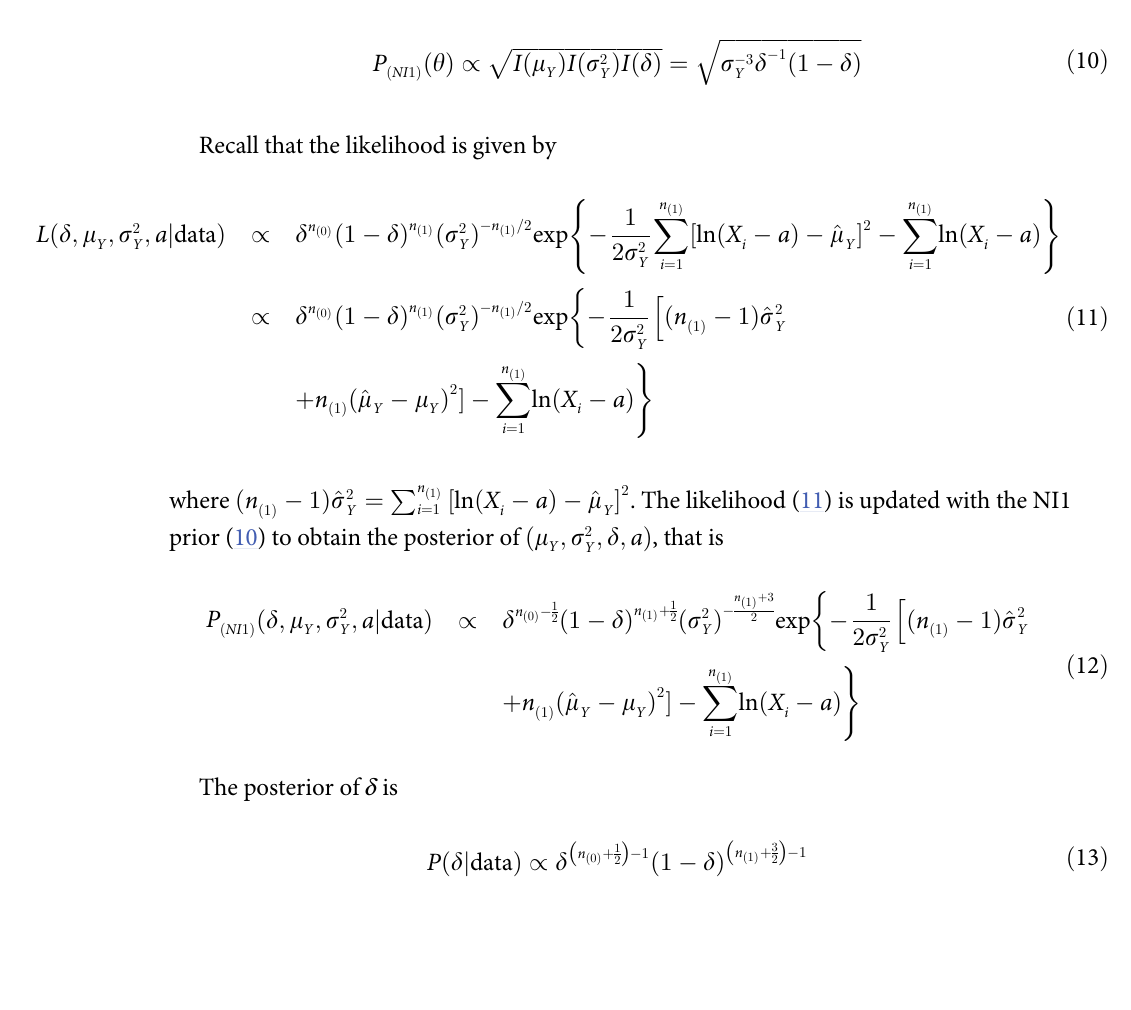
ffiffiffiffiffiffiffiffiffiffiffiffiffiffiffiffiffiffiffiffiffiffiffiffiffiffiffiffiffi p Þ I ð s 2 Þ I ð d Þ I ð m Y Y